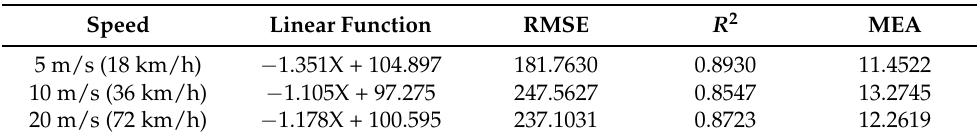
Table 7. The effect of the flight terrain on the performance; the results are presented for location #2 and an altitude of 50 m, at various speeds.